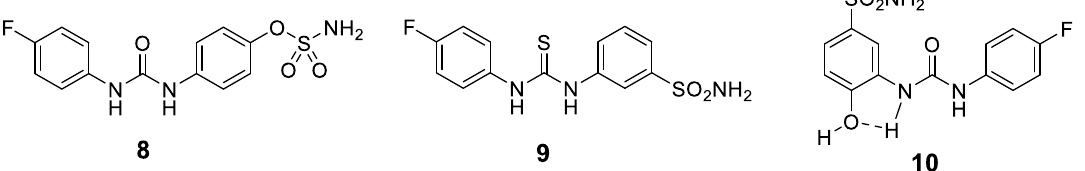
Figure 2. Chemical structures for SLC-0111 analogs ( 8 – 10 ) developed through modification of the SLC-0111 benzenesulfonamide